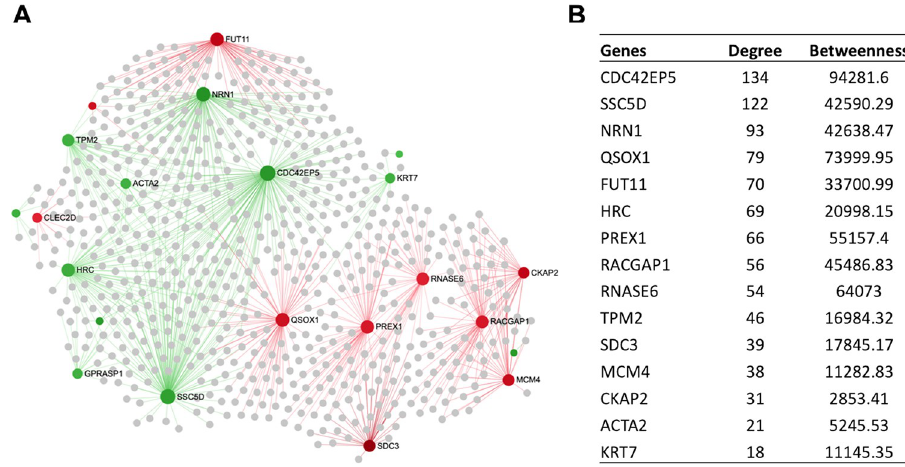
Fig 6. The liver-specific gene co-expression network generated from the